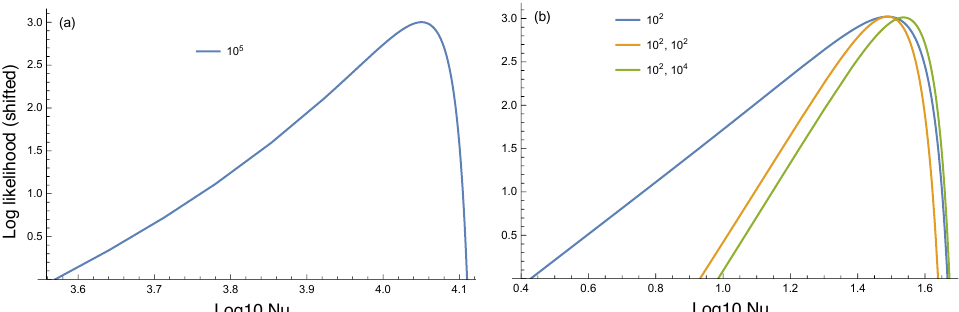
Figure 4. Log-likelihood for the parameter Nu given the values of the data shown in the legends of each plot. A constant was added to all log-likelihood values to shift the curves up so that the peaks are at a value of three. The zero values give the log-likelihood confidence intervals for which the most likely value is e 3 ≈ 20 times more likely that the lowest values shown at the edges of the intervals. ( a ) For a single observation of m = 10 5 , the most likely value is approximately Nu = 10 4.05 . ( b ) Log-likelihood curves for different data combinations. The first (blue) curve has a single observed value, whereas the other two curves arise from pairs of observed values. These likelihood curves derive from the Fréchet approximation in Equation